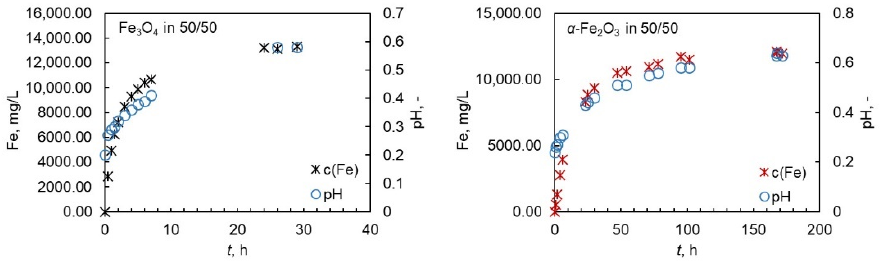
Figure 3. An illustrative example of behaviour of pH during the dissolution of magntite and hema- tite in Ox/HNO 3 system at 50